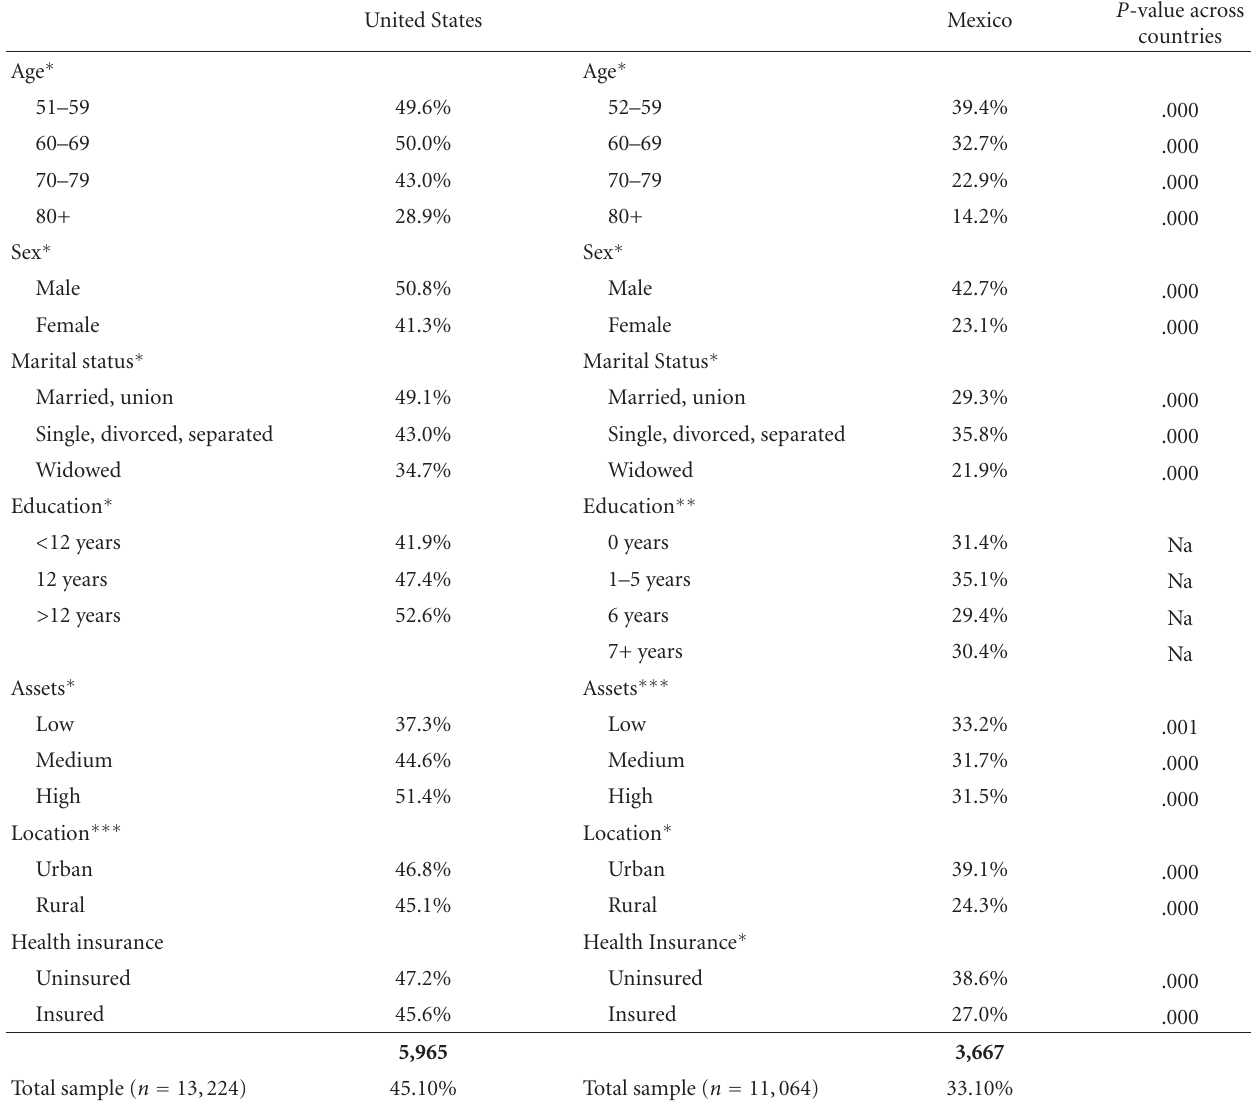
Table 3: Prevalence of physical activity at time 1 according to main characteristics, by